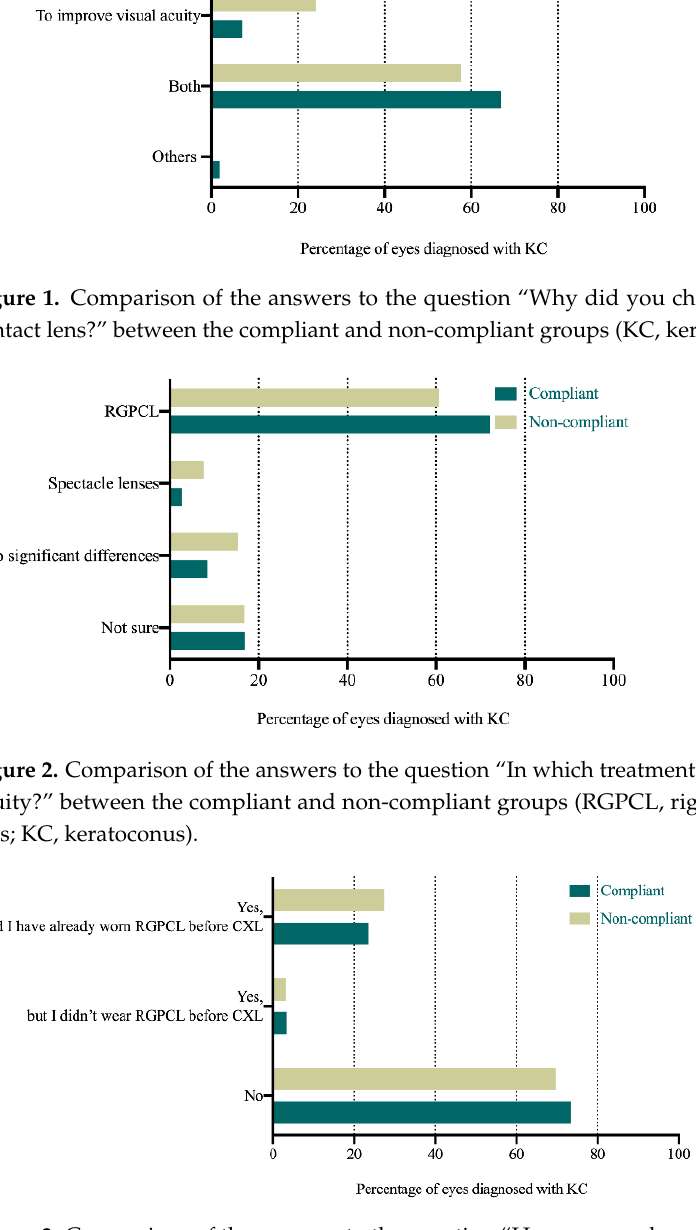
Figure 3. Comparison of the answers to the question “Have you undergone corneal collagen cross- linking surgery?” between the compliant and non-compliant groups (RGPCL, rigid gas-permeable contact lens; CXL, corneal collagen cross-linking; KC, keratoconus).